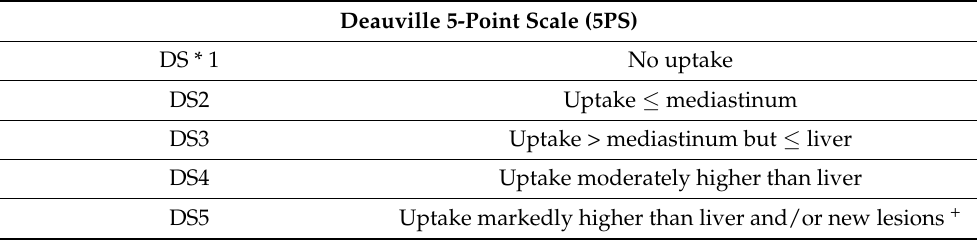
Table 2. Lugano classification and deauville 5-point scale (D5PS) in FDG-avid